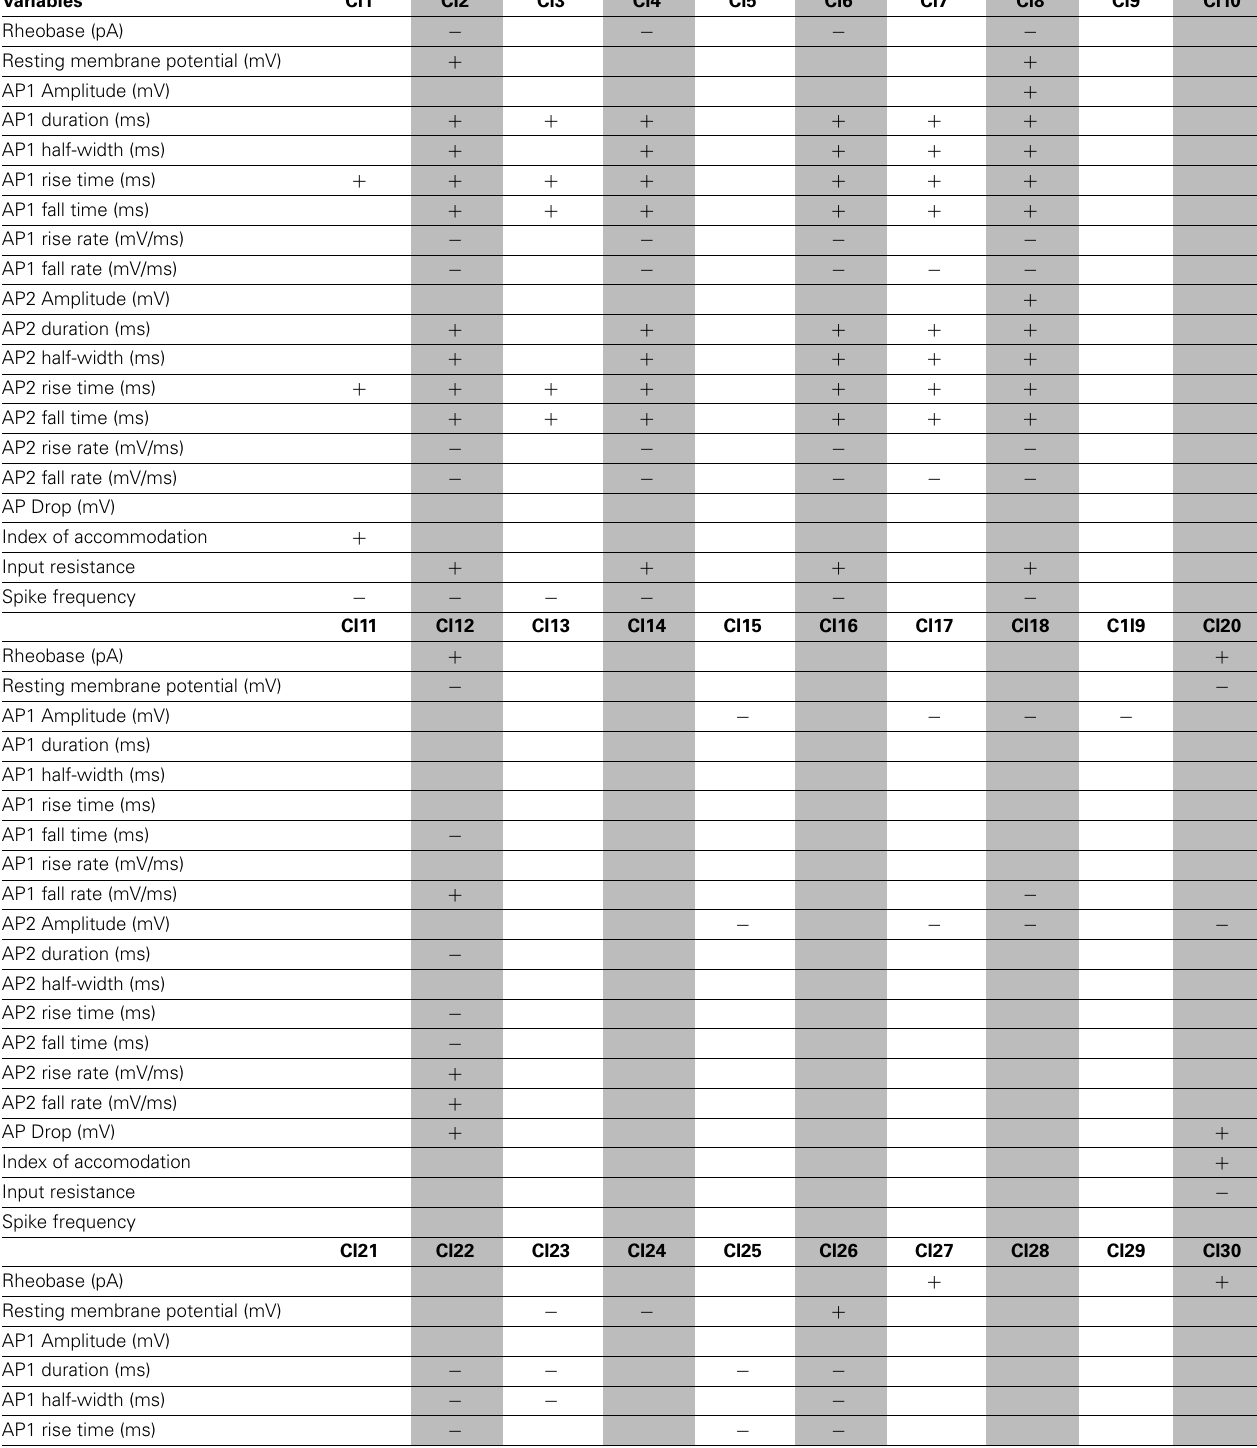
Table 3 | Significant variables for each physiological